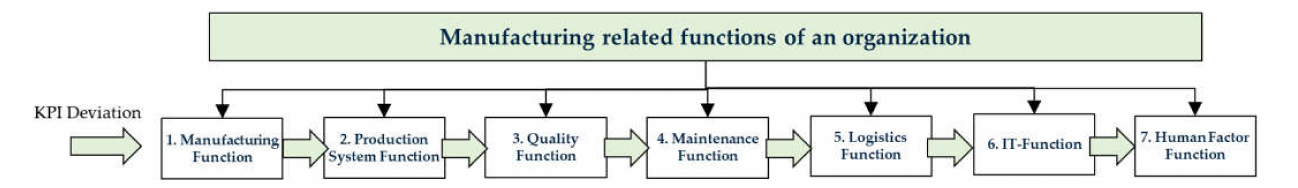
Figure 6. FMEA Process for Function limitation or bottleneck: diagnosis sequence at the organiza- tional functional areas level (the authors’ own